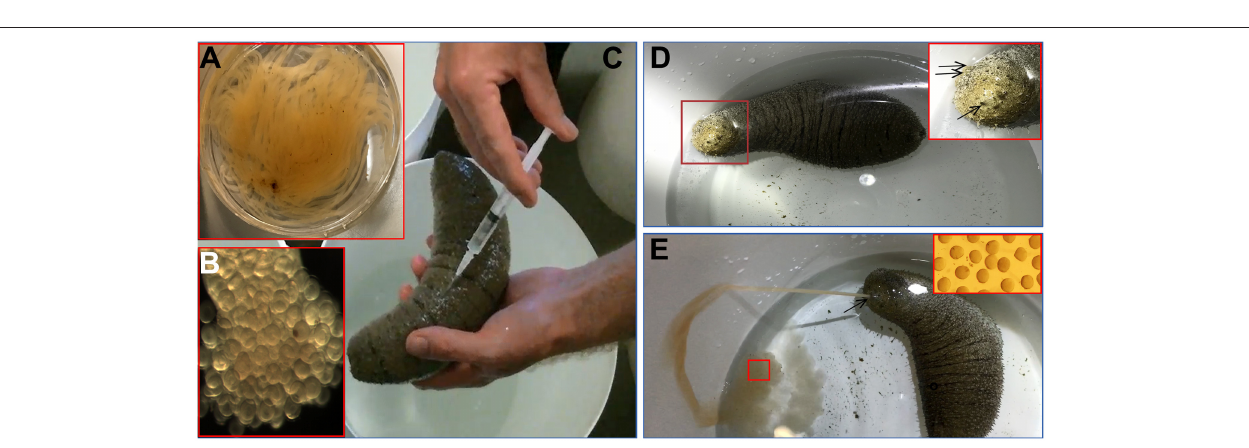
FIGURE 6 | Holothuria scabra spawning bioassay with recombinant RGP. (A) Total gonad from an individual showing tubules. (B) Immature oocytes (170 ± 6.4 µ m in diameter) with germinal vesicle before spawning. (C) Injection of sample into the body wall. (D) Head waving observed prior to spawning. Inset, higher magnification of sea cucumber head (red box), showing the location of gonopore (single arrow) and mouth (double arrow). (E) Sea cucumber spawning oocytes from gonopore. Inset, high magnification view of spawned oocytes (red box) indicating they were